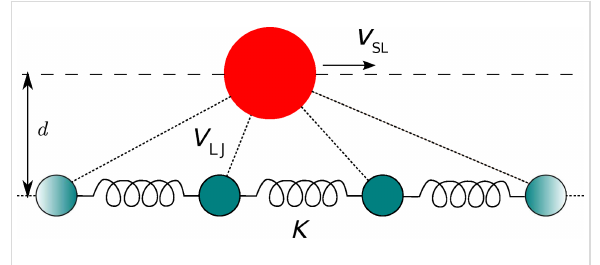
Figure 1: A sketch of the 1D slider-substrate model. The large sphere represents the slider, which moves along a fixed line (dashed) and interacts via Lennard–Jones forces with all atoms in the harmonic chain (smaller spheres).